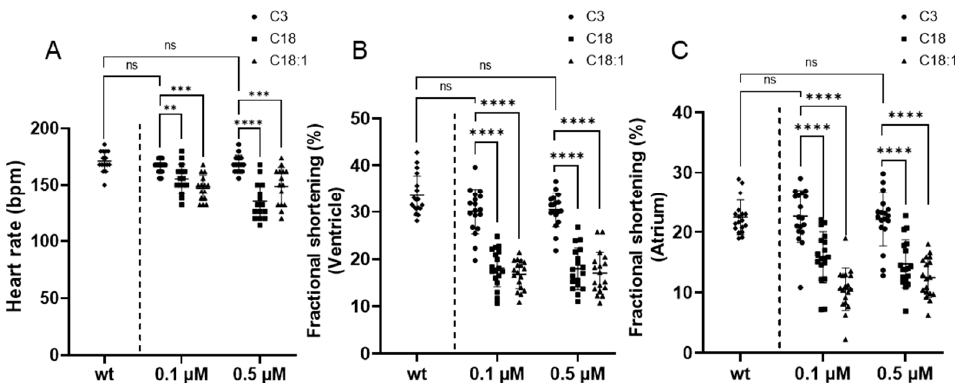
Figure 7. Cardiac dysfunction of zebrafish embryonic hearts resulting from LCAC treatment. ( A ) Comparison of heart rates between wt and compound-treated larvae. ( B , C ) Contractility of heart chambers (ventricle and atrium) after compound treatments compared to wt (SD, n = 15, ns: p > 0.05, ** p < 0.01, *** p < 0.001, **** p < 0.0001). Abbreviations: ns = not significant, wt = wild-type.